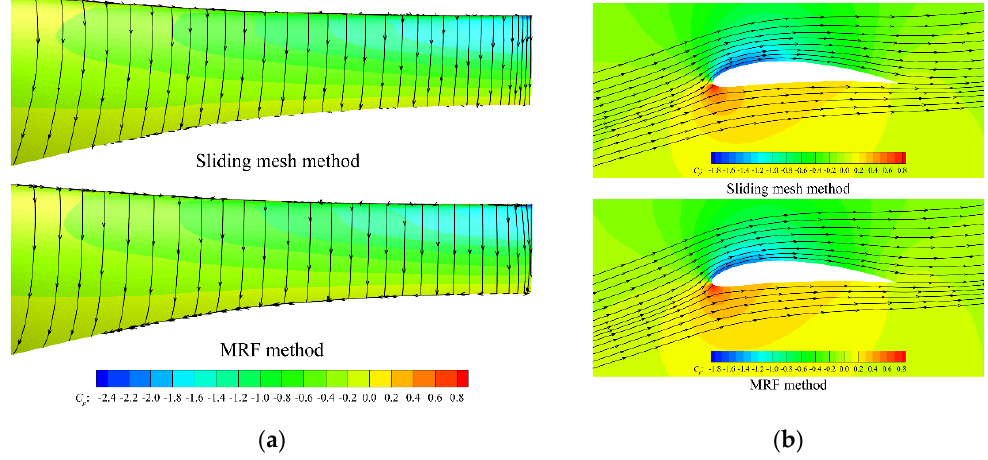
Figure 7. Comparison of streamlines obtained via sliding mesh method and MRF method, with pressure coefficients contour as background: ( a ) limiting streamlines on suction side of blade; ( b ) streamlines on cross section at r/R b = 0.99.